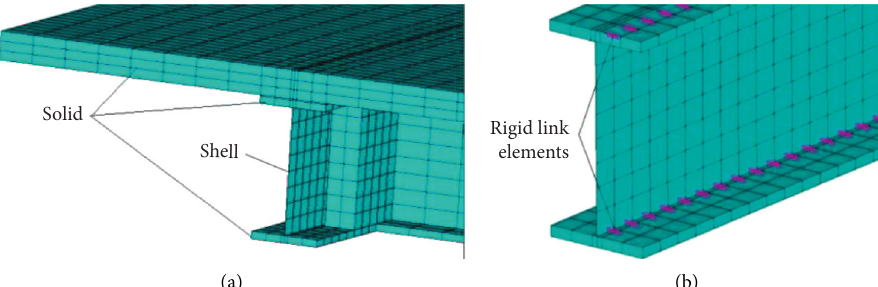
Figure 6: Finite element model and rigid connections of the GFRP-concrete hybrid girder. (a) 3D finite element model. (b) Detail of rigid connections. Table 3: Comparison the mid-span deflection and neutral axis position of test girder between the FE values and measured values. Static test FE model Experimental Mid-span average deflection (mm) 7.24 6.79 Neutral axis position (mm) 31.19 24.55